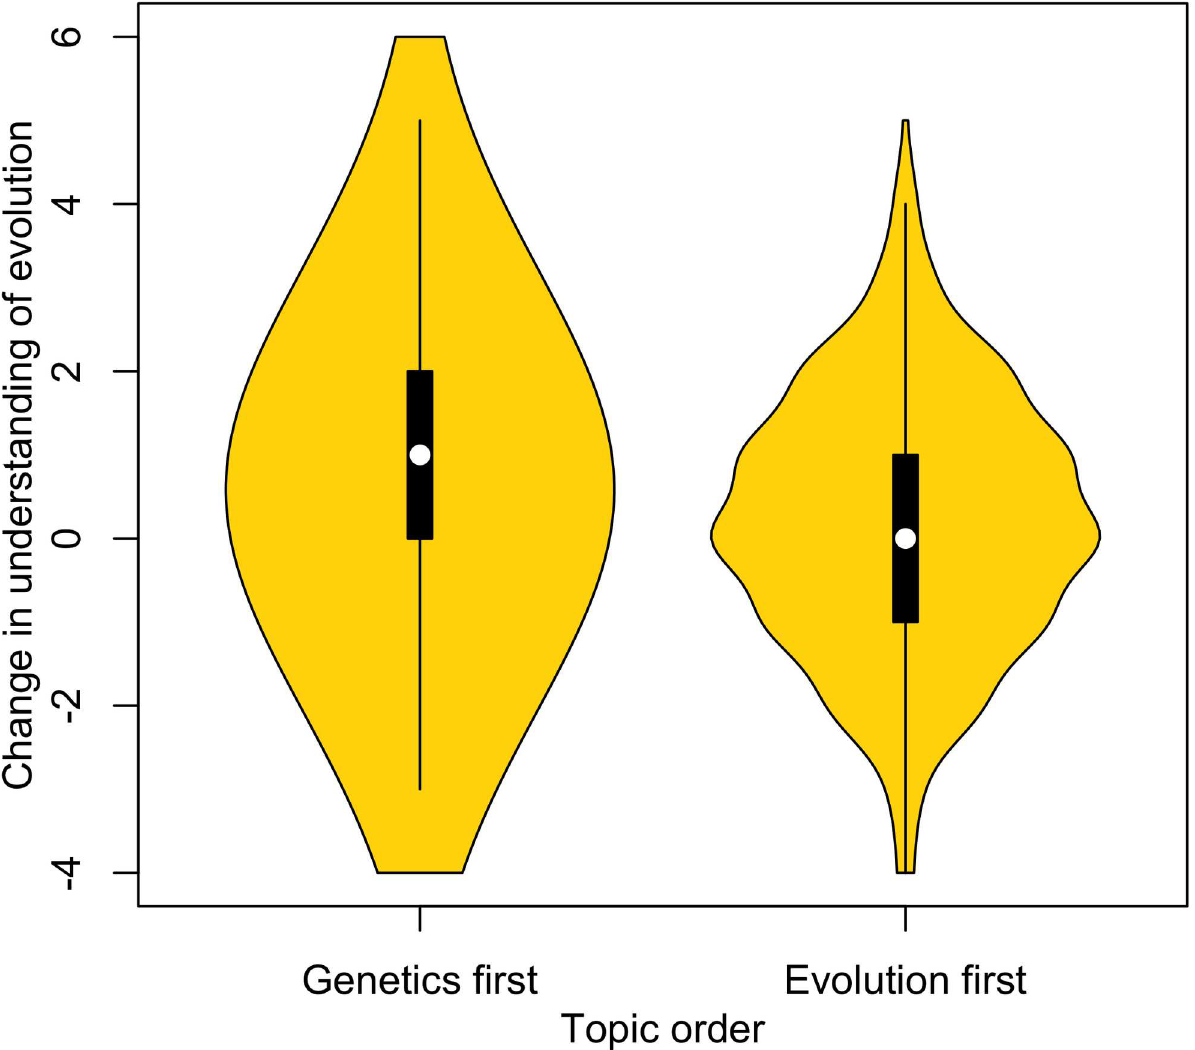
Fig 3. Change in understanding of evolution (i.e., after teaching − before) for different topic orders (genetics first: n = 779, evolution first: n = 454). Raw data can be found in S1 and S2